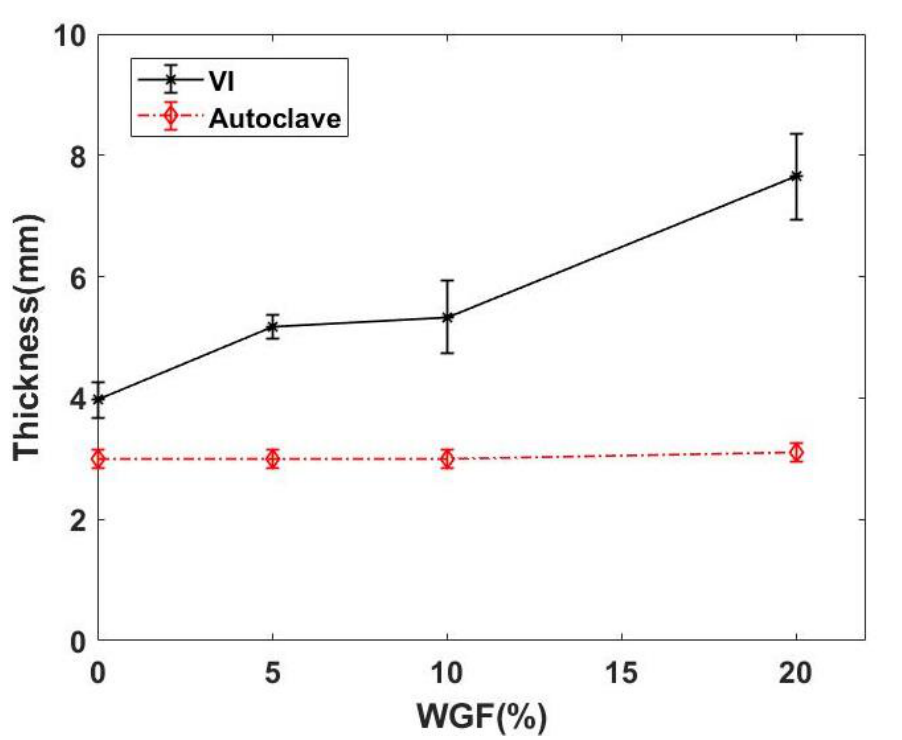
Figure 6. Average thickness of WGF composites manufactured using two different